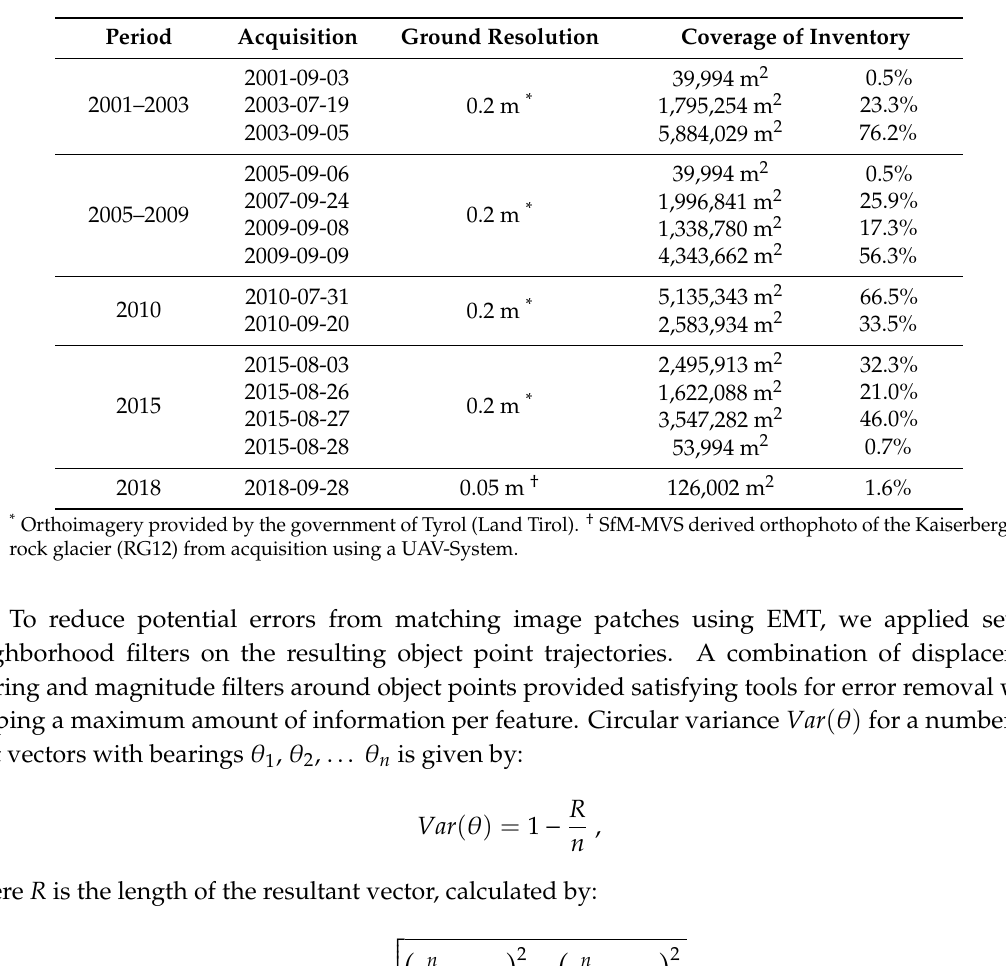
Table 1. Available aerial imagery for the Kaunertal rock glaciers between 2001 and 2018. Coverage is given in m 2 and as a percentage share of the rock glacier